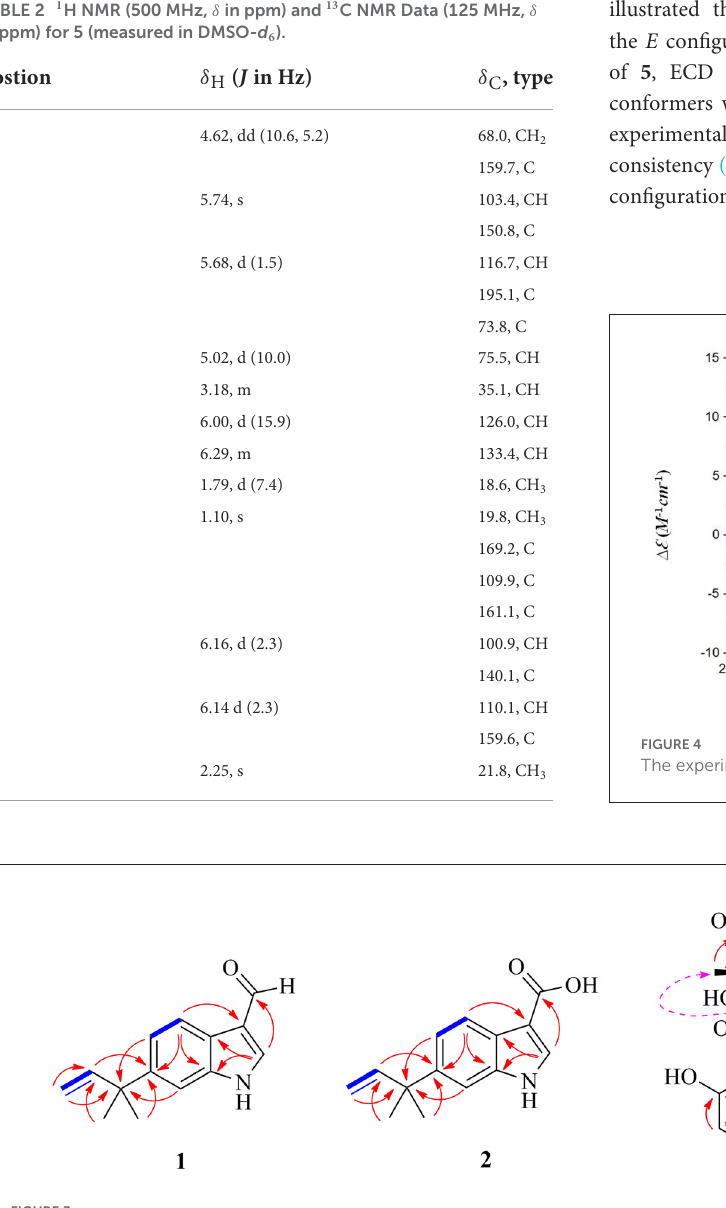
FIGURE3 Selected Homonuclear chemical shift Correlation Spectroscopy (COSY), eteronuclear Multiple-Bond Correlation (HMBC), and Nuclear Overhauser Effect Spectroscopy (NOESY) correlations of 1 , 2 , and 5